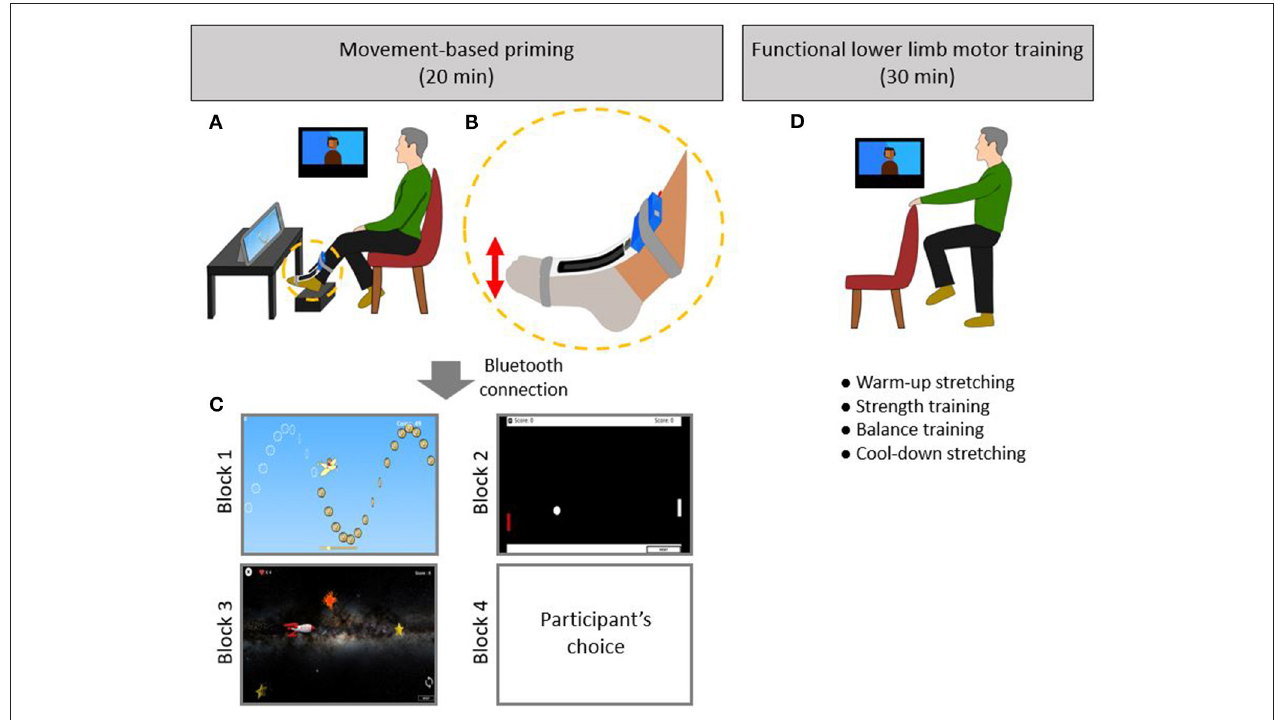
FIGURE 1 | (A) DIG-I-PRIME TM system setting with remote supervision via videoconference for 20-min of movement-based priming. (B) DIG-I-PRIME TM foot piece consists of a microcontroller (blue) and a bend sensor (black). The bend sensor was centered on the dorsum of the paretic foot while the microcontroller faced the participant. The DIG-I-PRIME TM foot piece was supported by Velcro straps (dark gray). The DIG-I-PRIME TM foot piece wirelessly transmitted information regarding foot orientation in the sagittal plane during ankle dorsiflexion and plantarflexion movements to the tablet via Bluetooth connection. (C) Four blocks of video games (5-min each) were played using the tablet placed in front of the participants. Three games, which included Treasure Hunt (Block 1), Ping-Pong (Block 2), and Shooting Stars (Block 3), were played. The participant chose on of these three games for Block 4. (D) Following 20-min of priming, participants performed 30min of functional lower limb motor training under remotely